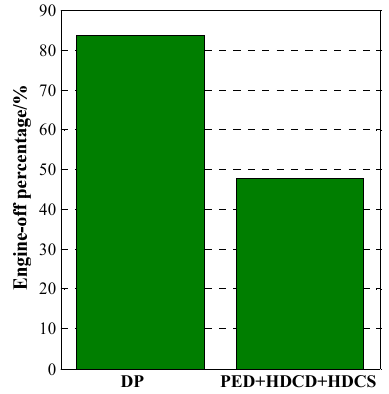
Figure 19. The ICE shutdown percentage under the two types of strategies.